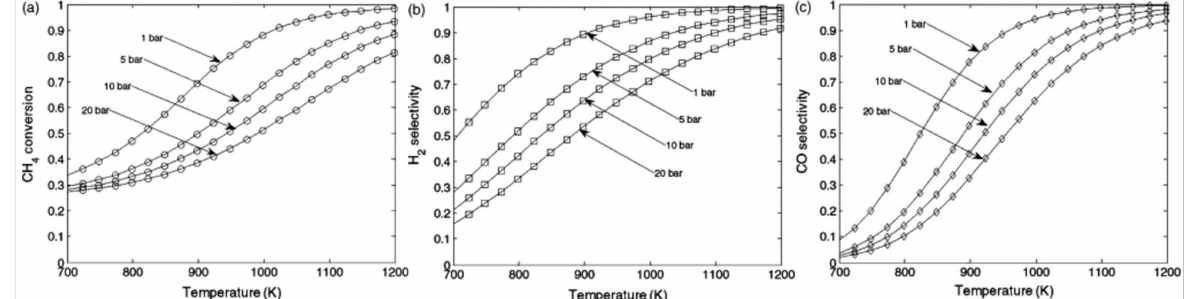
Figure 5. Thermodynamic equilibrium plot for CSDRM as a function of temperature (T = 700–1200 K) at 1–20 bar with CH 4 :O 2 = 2.0. ( a ) CH 4 conversion; ( b ) H 2 selectivity; ( c ) CO selectivity. Reprinted with permission from [141]. Copyright 2008